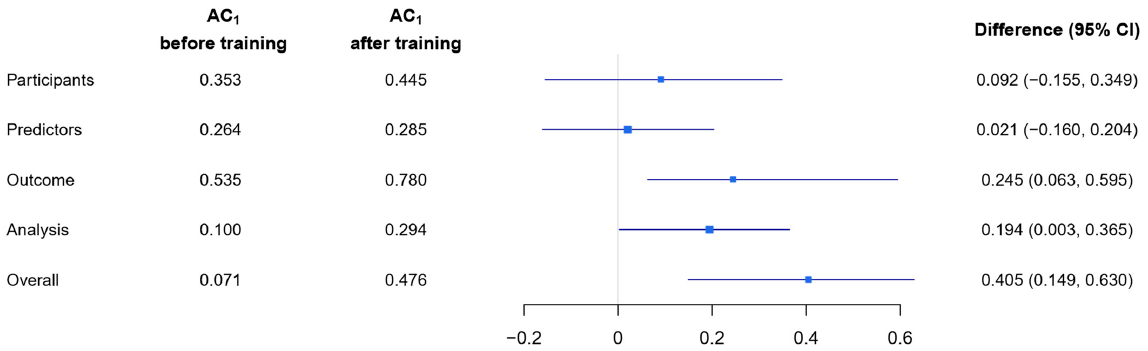
Figure 3. Multi-rater agreement in terms of AC 1 before and after training for the domain-specific and overall ROB ratings, as well as ∆ AC 1 estimates with bootstrapped 95%-CI.